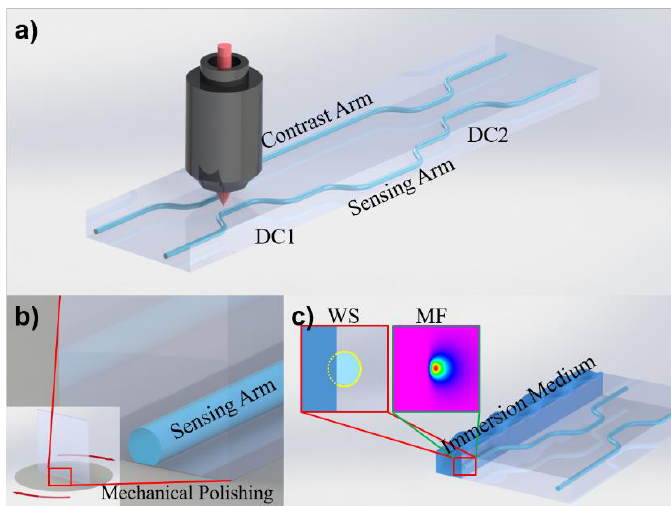
Figure 1. Schematic illustrations of ( a ) femtosecond laser direct writing of an asymmetric on-chip MZ interferometer, ( b ) mechanical polishing of the sensing arm side, and ( c ) the cross section of the device after immersion in the liquid to be measured. The front view of the waveguide section (WS) is shown in the red box, and the mode field (MF) distribution of the waveguide is shown in the green box.